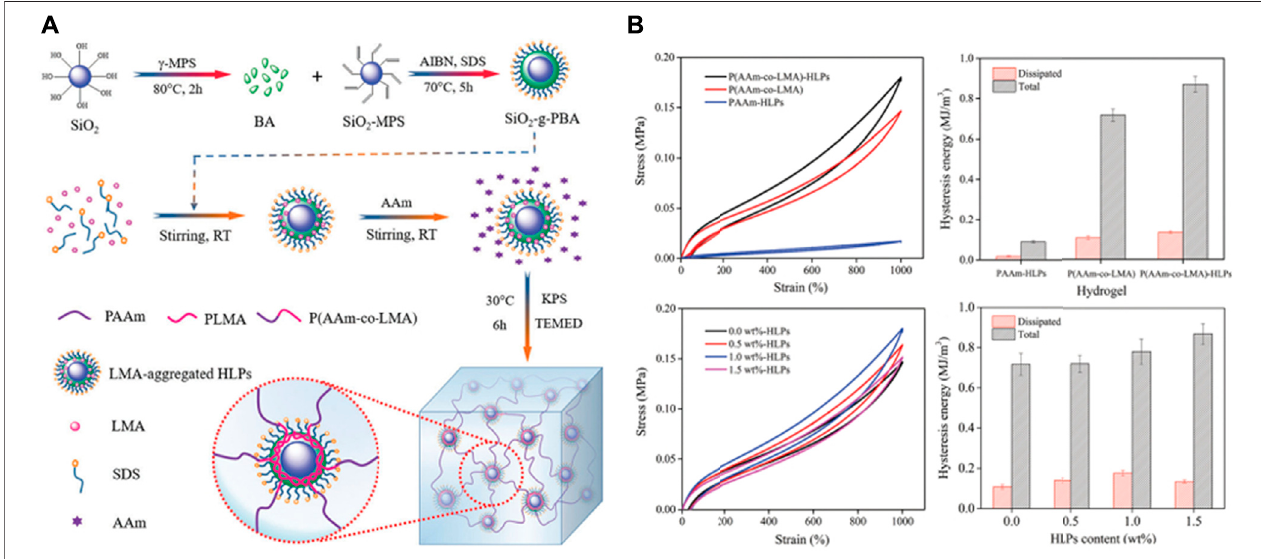
FIGURE 1 | (A) Schematic representation of nanocomposite hydrogels reinforced by core-shell SiO 2 -g-PBA hybrid latex particles; (B) Loading – unloading cycle behaviors of SiO 2 incorporated nanocomposite hydrogels. Reproduced from Xia et al. (2017) with permission from Copyright 2017 Royal Society of Chemistry.